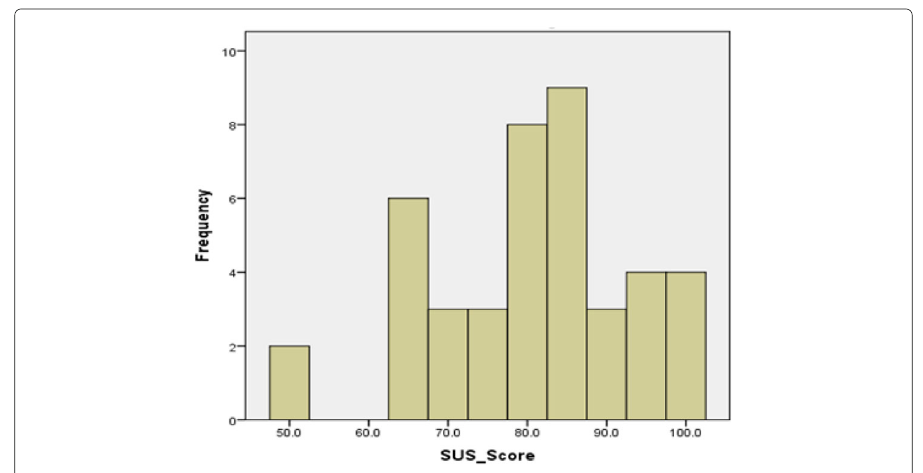
Fig. 35 Histogram of the SUS scores of the BOS UI